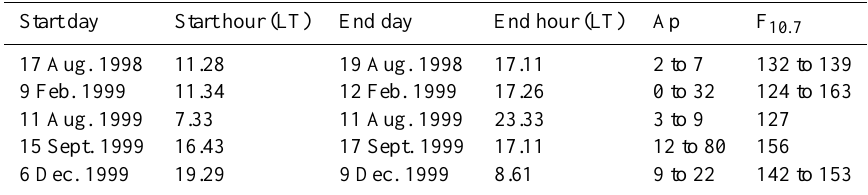
Table 1. Characteristics of the five experiments (decimal